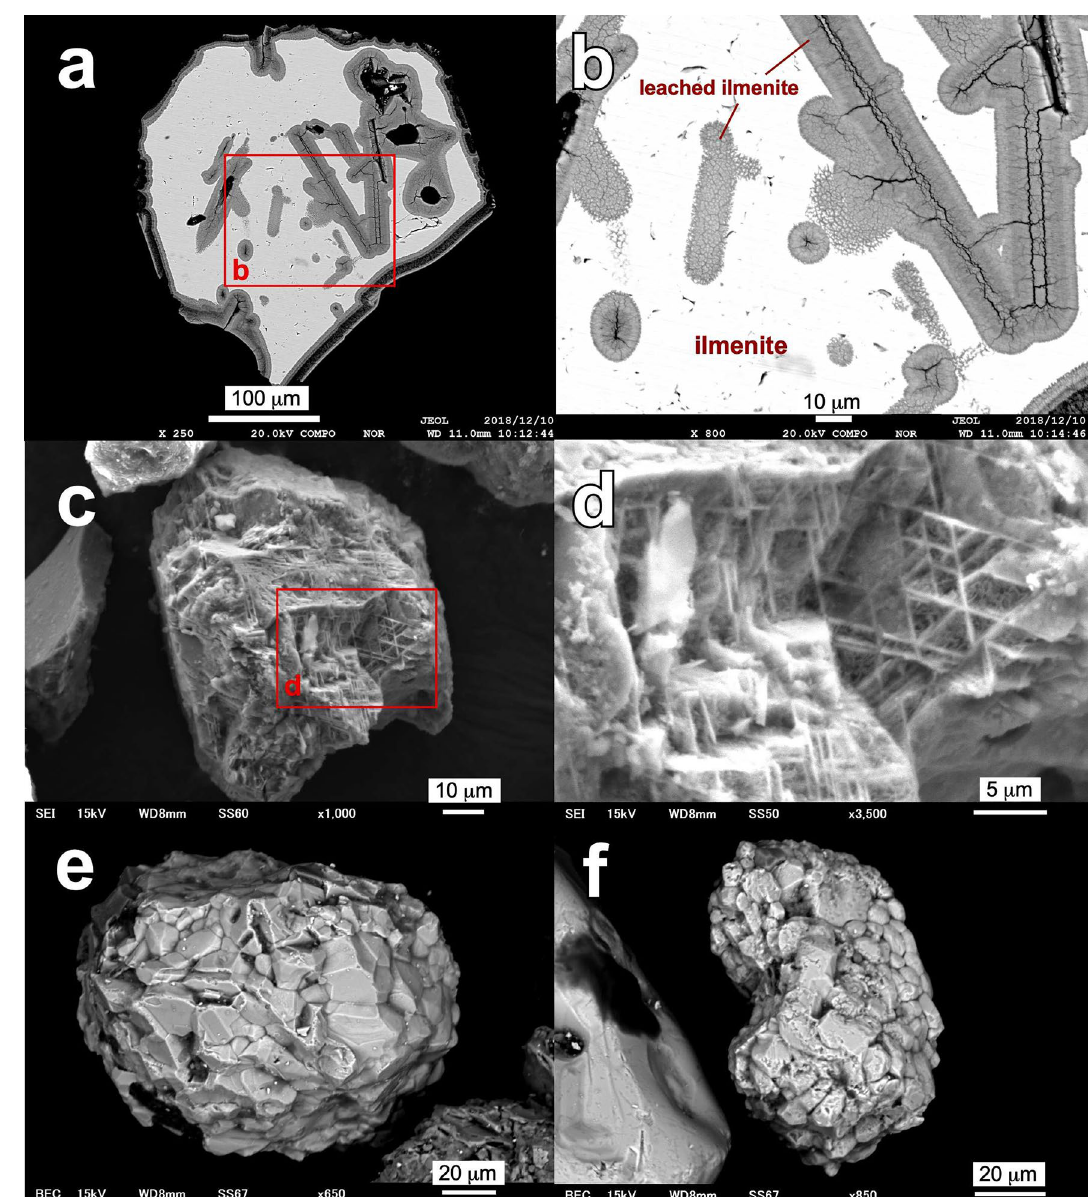
Figure 7. Electron micrographs showing the occurrences of ilmenite in gaerome and kibushi clay. BSE images ( a , b ) (a polished section) show leached ilmenite in an ilmenite grain of the gaerome clay (A07), indicating leached ilmenite as an alteration product of ilmenite. SEI ( c , d ) show a strongly corroded ilmenite grain in the kibushi clay (A08). BSE images ( e , f ) show framboid-like aggregates of ilmenite-pseudorutile in the kibushi clay